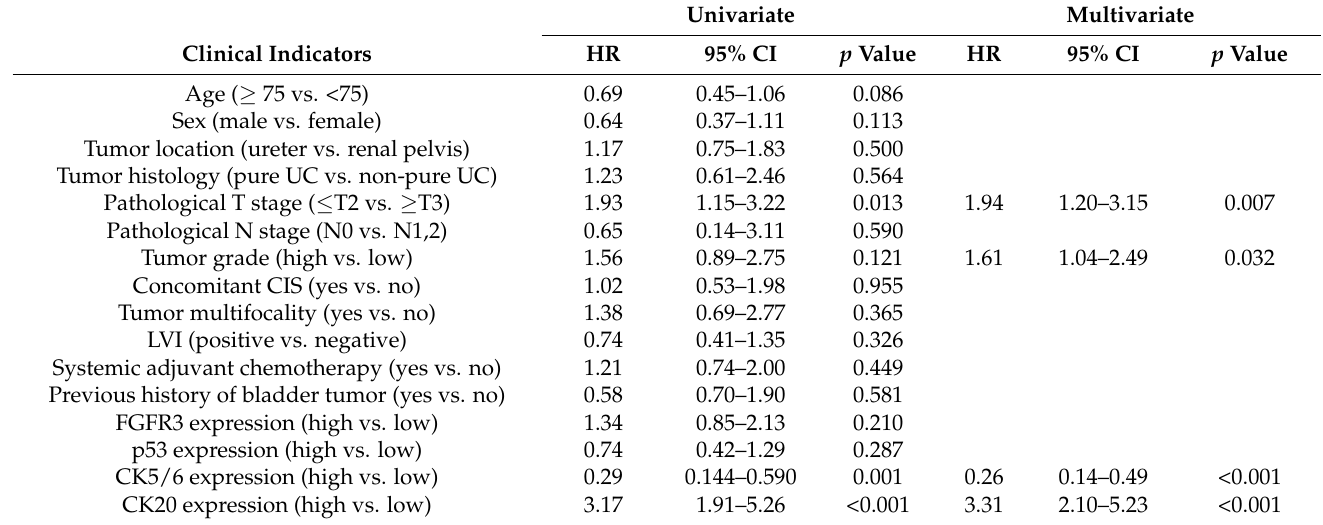
Table 2. Uni- and multivariate Cox regression analyses for determining risk factors for IVR develop- ment in UTUC patients. Abbreviations: IVR; intravesical recurrence, UTUC; upper tract urothelial carcinoma, HR; hazard ratio, CI; confidence interval, UC; urothelial carcinoma, CIS; carcinoma in situ, LVI; lymphovascular invasion, FGFR; fibroblast growth factor receptor, CK; cytokeratin. Univariate